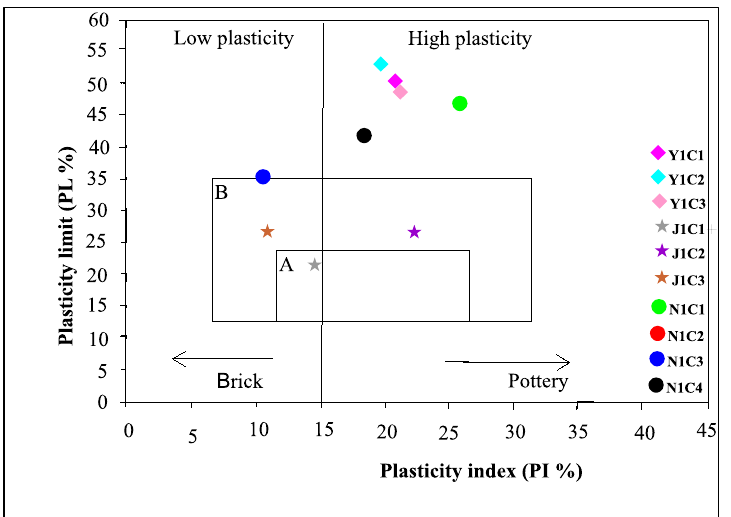
Figure 14. Potential molding of the analyzed clayey materials according to Bain diagram